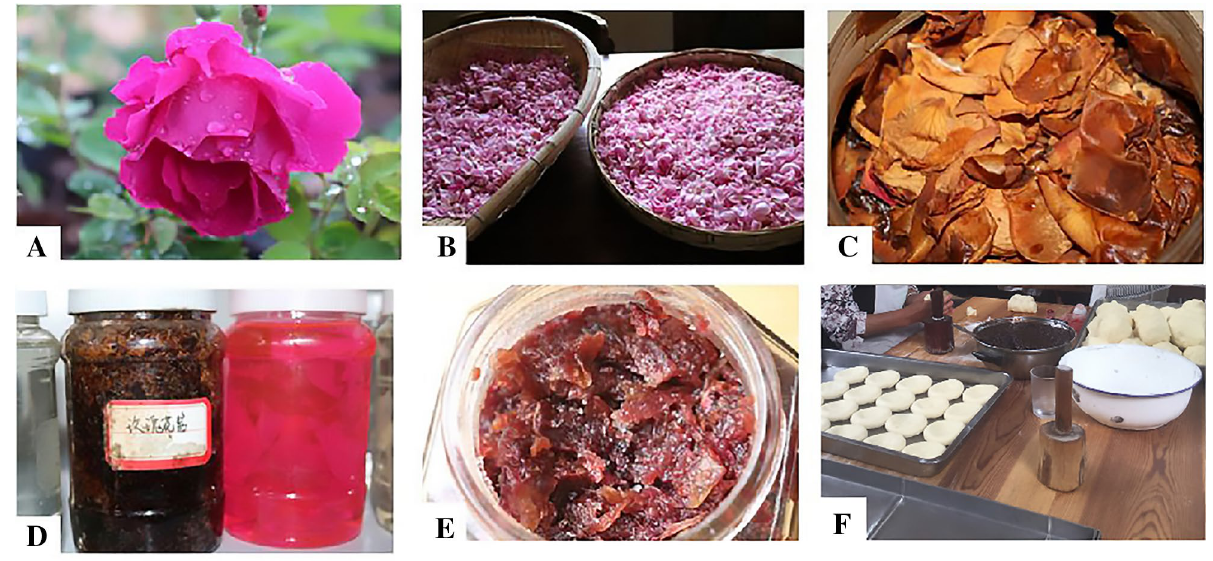
Figure 1. Traditional uses of Rosa by Bai people in Dali, northwest Yunnan: ( A ) Rosa. ‘Dianhong’. ( B ) Drying fresh Rosa petals to remove rain and dew. ( C , D and E ) Traditional fermented Rosa and ( F ) Cake workshop of traditional fermented Rosa in Heqing, Dali.